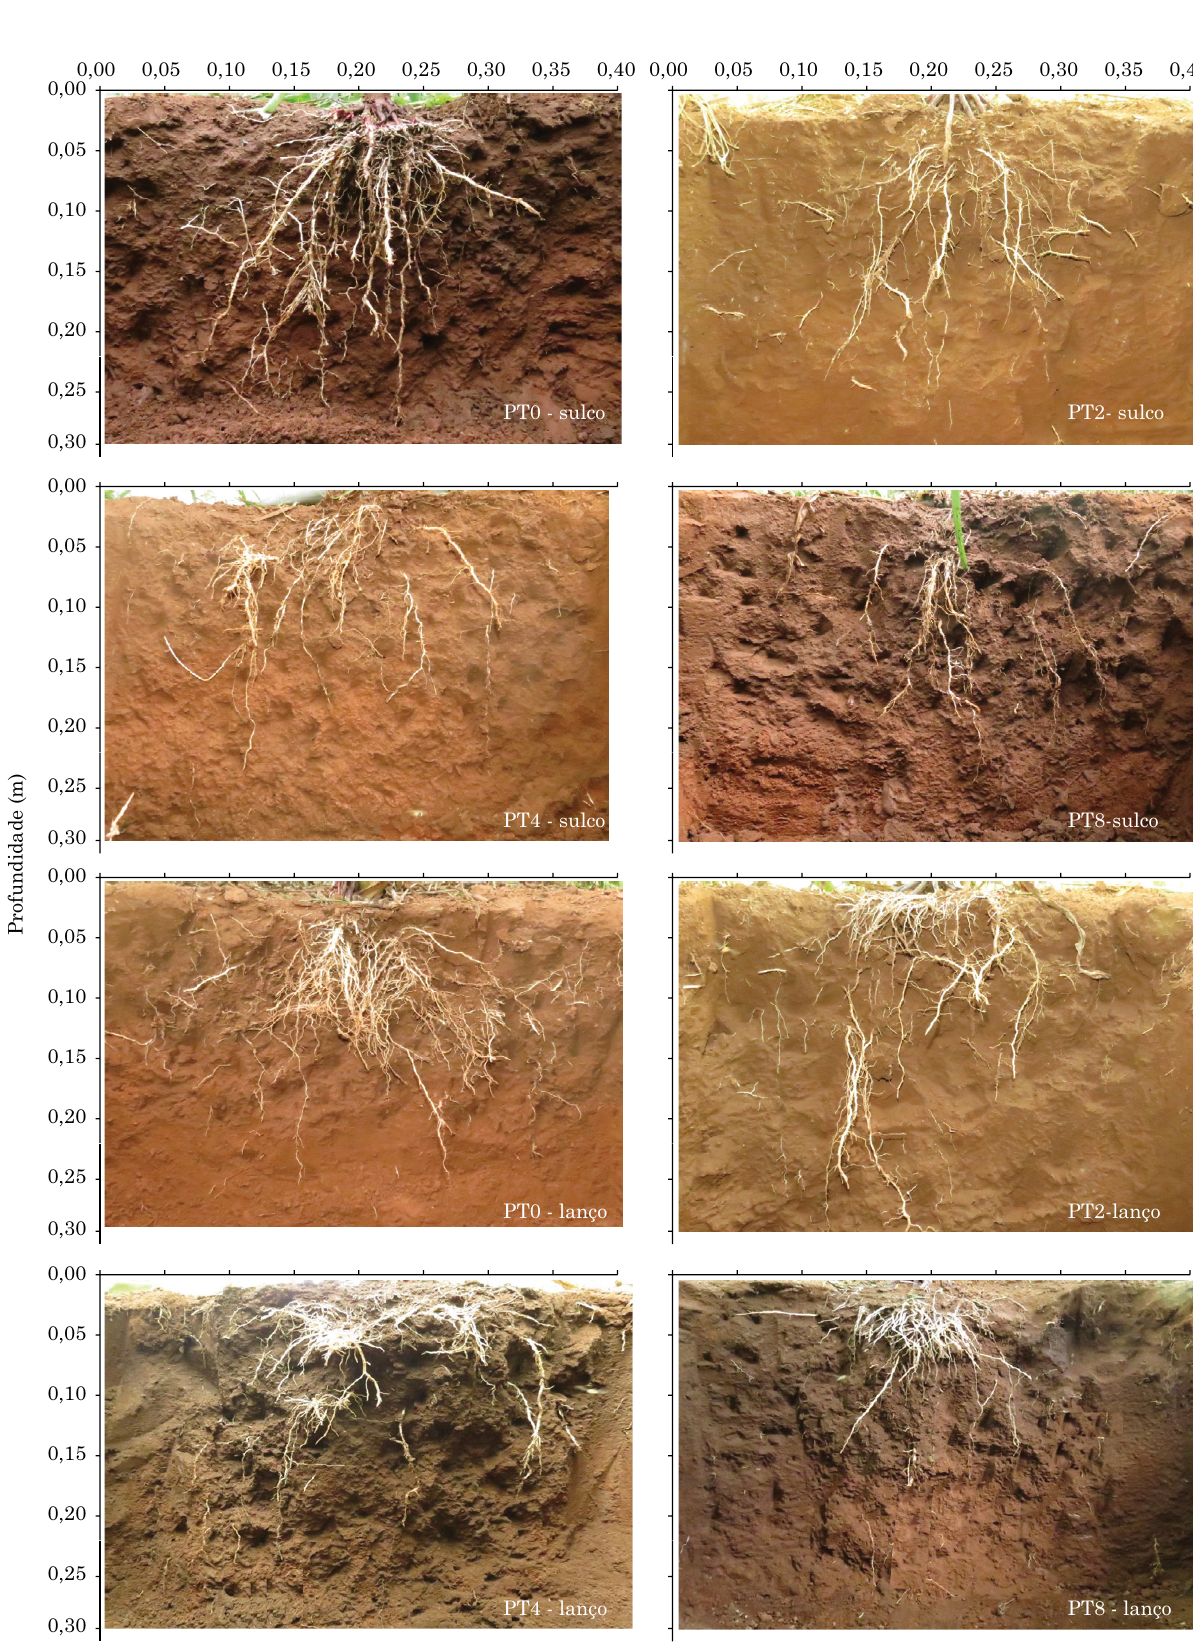
Figura 5. Distribuição das raízes do milho até 30 cm de profundidade do solo em decorrência de: zero (PT0), duas (PT2), quatro (PT4) e oito (PT8) passadas de